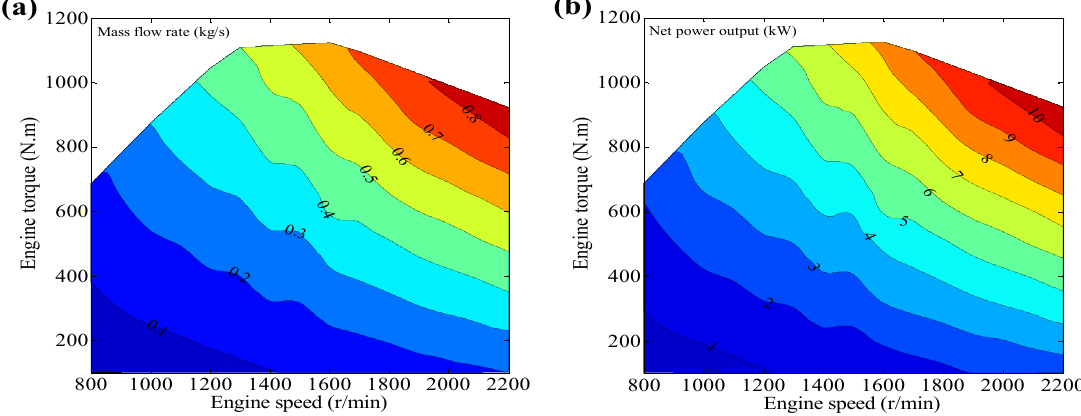
Figure 10. ( a ) The working fluid mass flow rate of the HT cycle; ( b ) The net power output of the HT